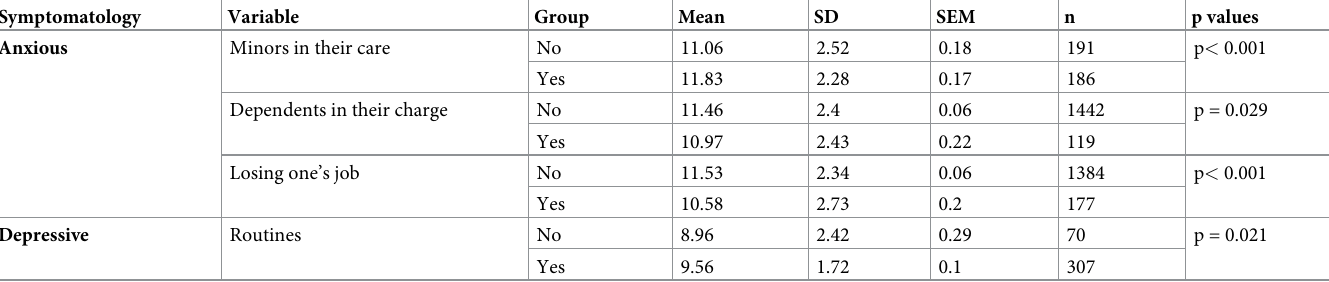
Table 5. Lockdown variables that were significantly related to anxious and depressive symptomatology.